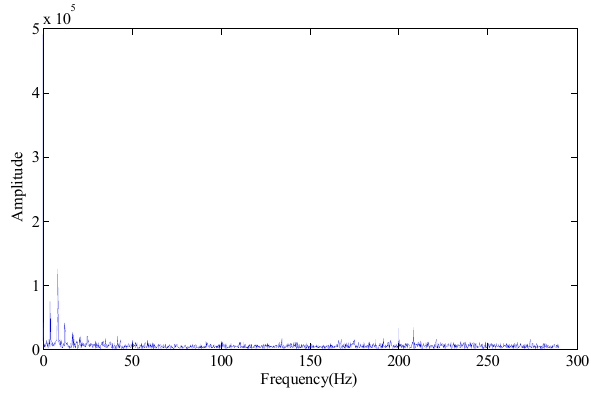
Figure 4. Envelope spectrum (singular values 1~4 set to 0).